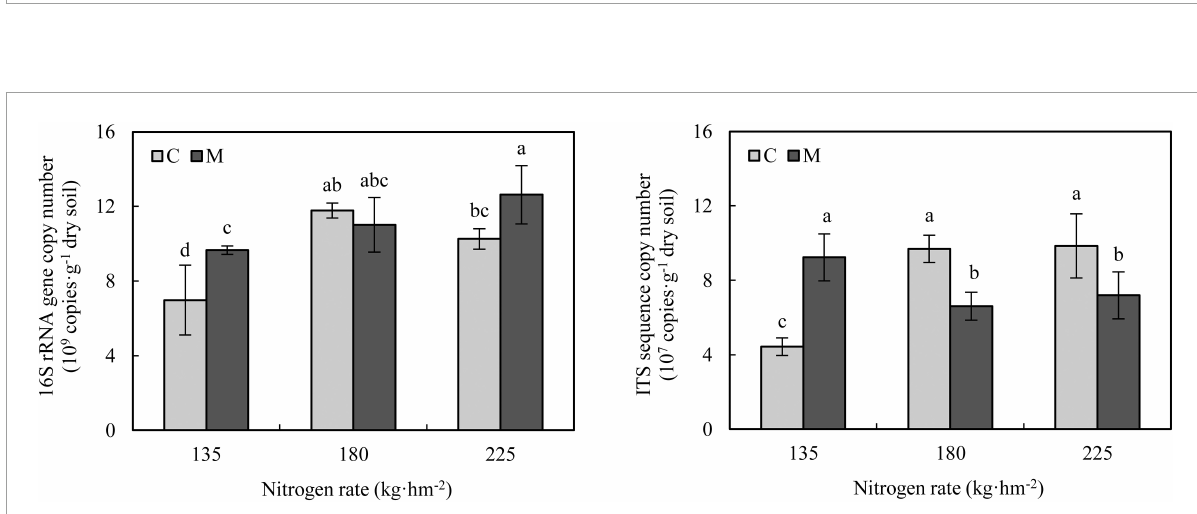
FIGURE2 Soil microbial abundance under different nitrogen and manure treatments. M and C indicate treatments with and without chicken manure application, respectively. Error bars represent standard deviations ( n = 3). Different letters above bars indicate significant difference at 0.05